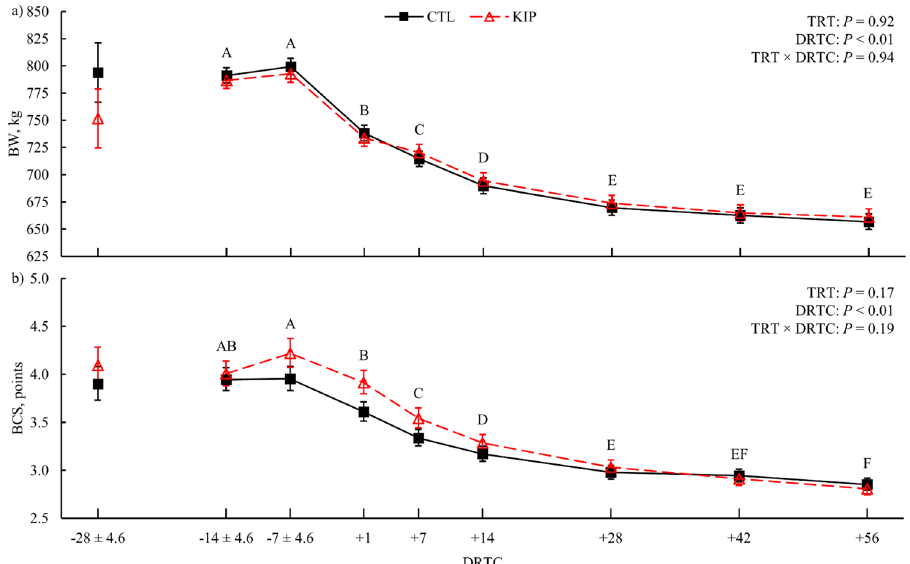
Figure 1. Body weight (BW) and body condition score (BCS) across the experimental period for control (CTL) and ketosis induction protocol (KIP) treatments (TRT). Error bars represent the 68% confidence limits of the least squares mean. The − 28 expected days relative to calving (DRTC) values were included as model covariates for their respective response; values graphically represented for − 28 expected DRTC are the arithmetic means. Variance in the actual DRTC sampled is represented for the relevant prepartum timepoints (± standard deviation). Differences across DRTC ( P ≤ 0.05, Tukey’s adjustment) are indicated when alphabetic superscripts do not share